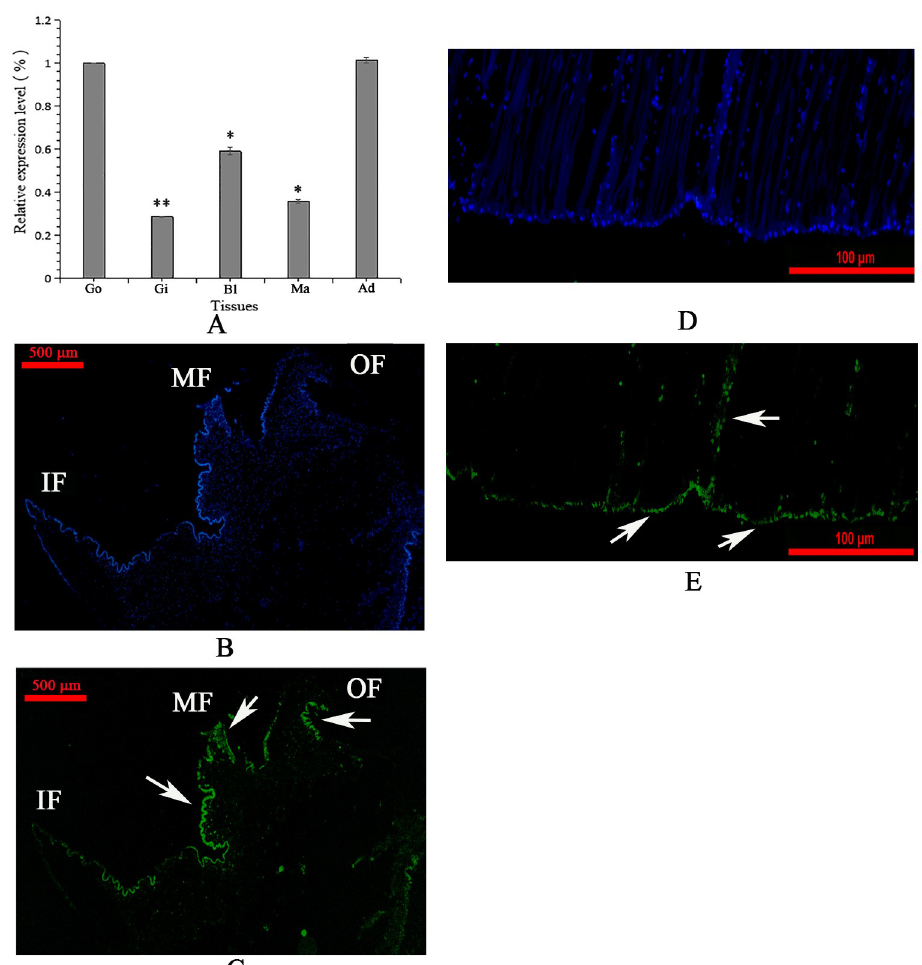
Fig 2. Tissue-specific expression (A) and in situ hybridization (B-E) of WLP gene. Go, gonad; Gi, gill; Bl, blood cell; Ma, mantle; Ad, adductor muscle. Values for qRT-PCR are means ± SD of three replicates. Significant difference relative to the expression level of adductor muscle was indicated with asterisk ( � , p < 0.05; �� , p < 0.01). B: control sample of in situ hybridization in the mantle; C: expression of WLP (green color, denoted by white arrows) in the mantle; D: control sample of in situ hybridization in the adductor muscle; E: expression of WLP (green color, denoted by white arrows) in the adductor muscle. The scale bar, 500 μ m for B and C, and 100 μ m for D and E.